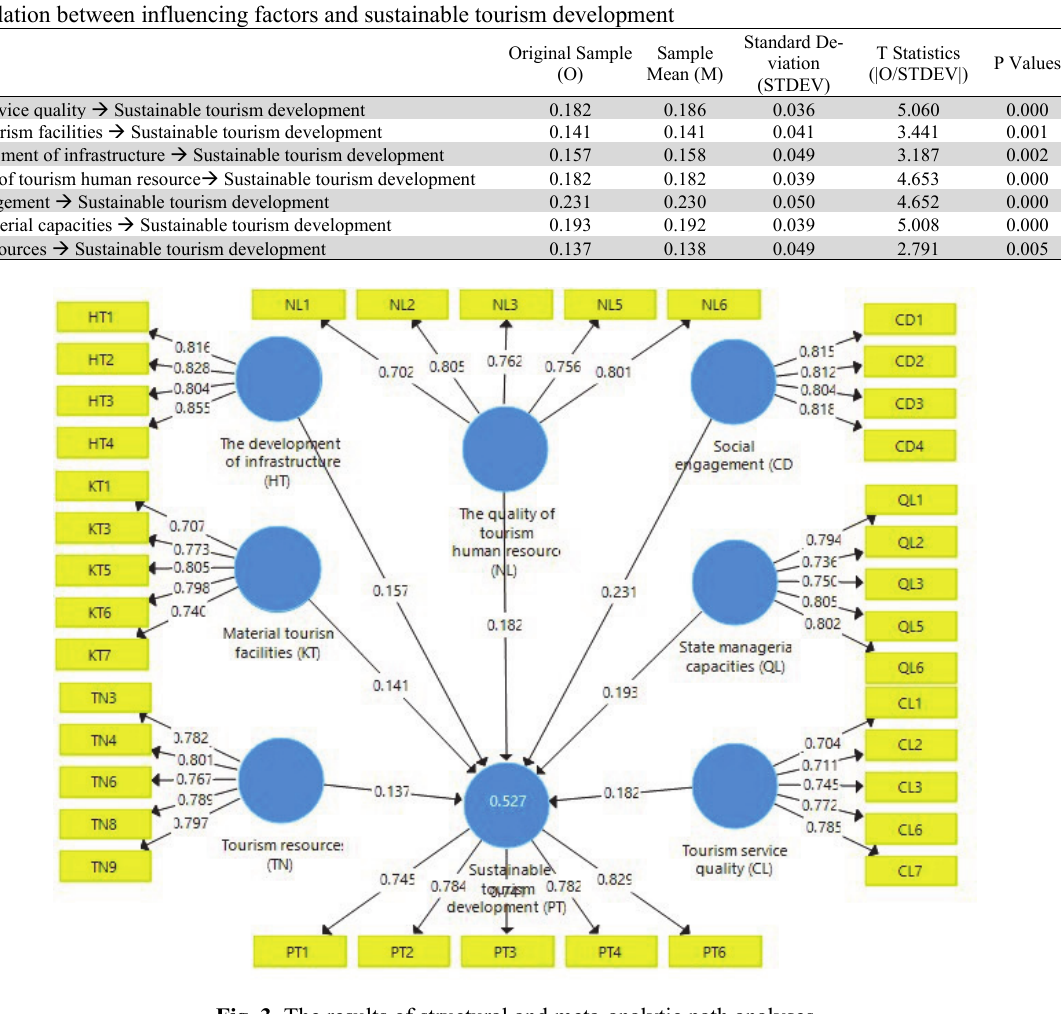
Fig. 3. The results of structural and meta-analytic path analyses Standardized Root Mean Square Residual (SRMR)